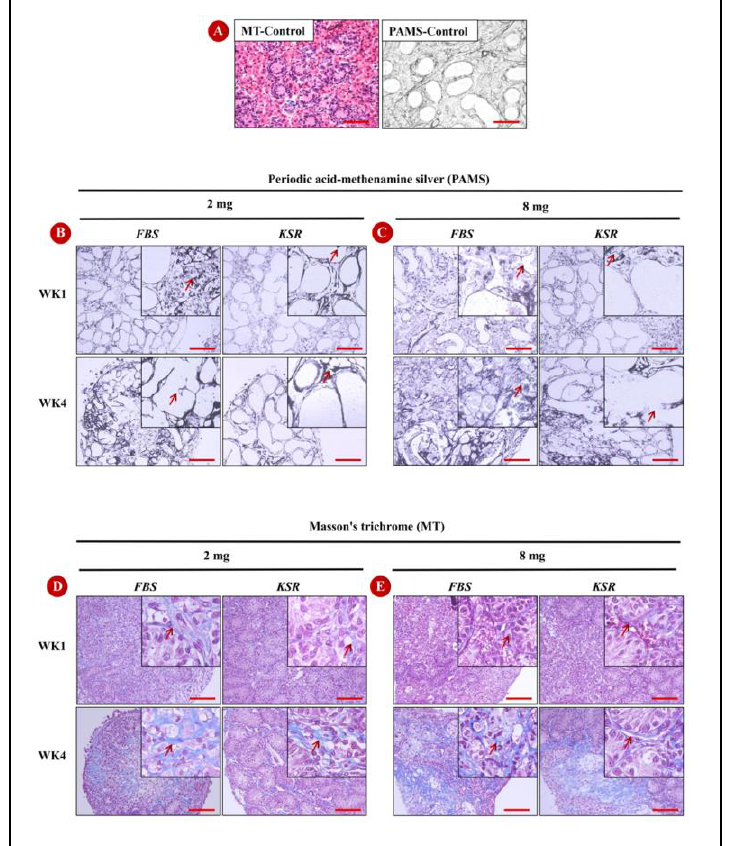
Figure 3. The effects of fragment size, media supplement, and week of culture on fibrosis and basement membrane of seminiferous tubules. ( A ) Representative photomicrographs of freshly isolated testicular tissue (control) stained with Masson’s trichrome (MT) to detect collagen fibers or periodic acid-methenamine silver (PAMS) to visualize the basement membrane of seminiferous cords (arrows). In these fresh samples, there are minimal collagen fibers present and no evidence of the basement membrane fragmentation. ( B , C ) PAMS staining of 2 and 8 mg tissue fragments, respectively, cultured in FBS or KSR for 1 or 4 weeks. Overall, tissue fragments cultured in FBS had more basement membrane fragmentation than those in KSR. ( D , E ) MT staining of 2 and 8 mg tissue fragments, respectively, cultured in FBS or KSR for 1 or 4 weeks. Week 4 samples of both sizes had stronger staining than week 1 samples, and tissue fragments cultured in FBS-supplemented media had stronger staining than those in KSR. Scale bar: 100 µ